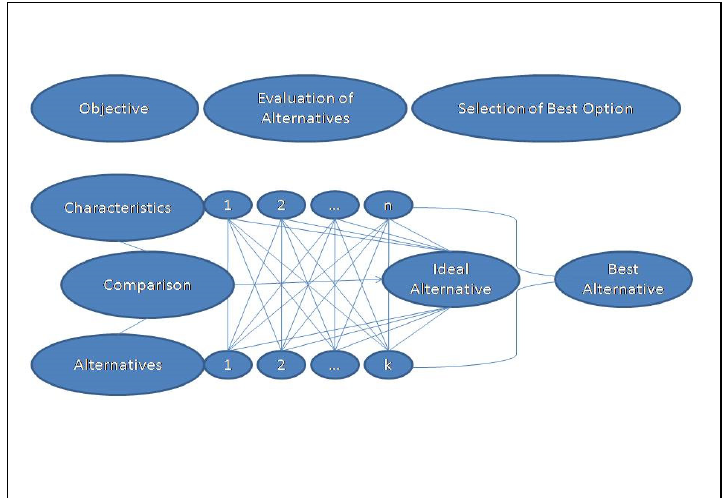
Figure 4. Graphical representation of SVN-MCDM